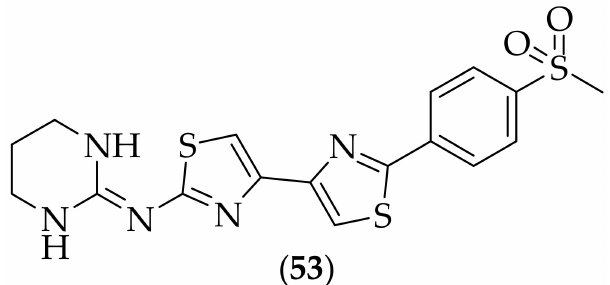
Figure 34. Guanidine-containing bis-thiazole analog antifungal agent ( 53 ).